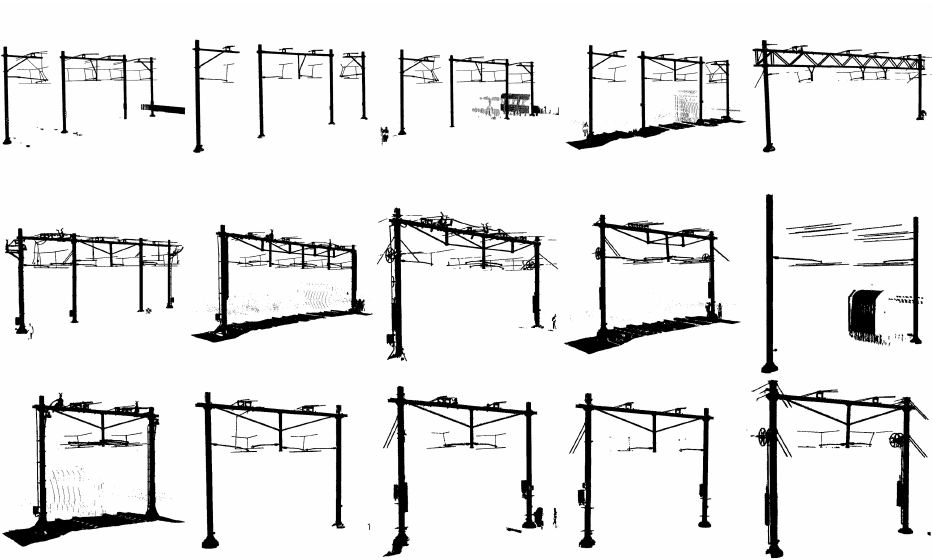
Figure 3. Overview of the dataset. Note the large variation of catenary arch types present in the dataset.